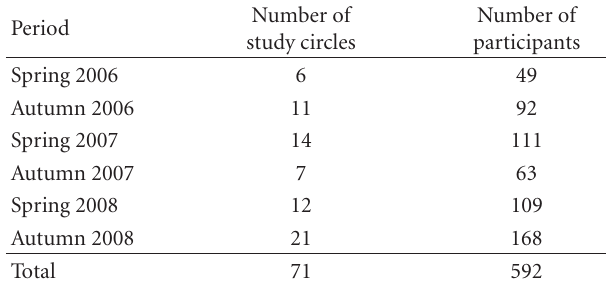
Table 2: Characteristics of participants and their evaluation of the study